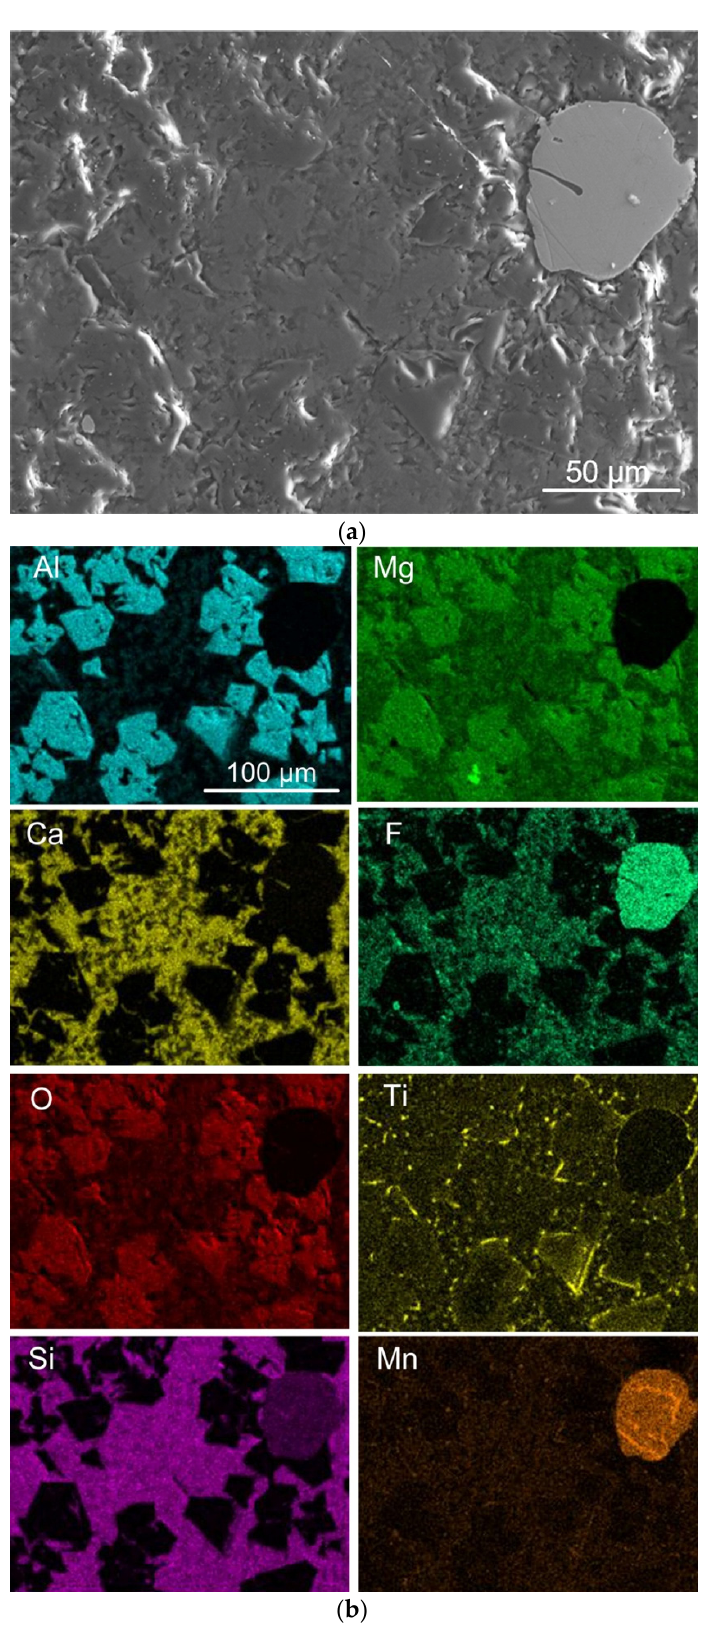
Figure 4. ( a ) BSE image of a smaller area in the MP1 slag sample. ( b ) EDX map of area in Figure 4a: MP1 slag sample.